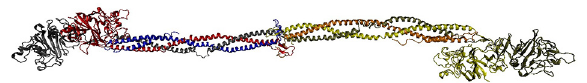
FIGURE 5 | Crystal structure of a hexameric complex formed by three fibrinogen chains, fibrinogen alpha (blue and orange chains), beta (red and yellow chains), and gamma (gray and tan chains) (PDB ID: